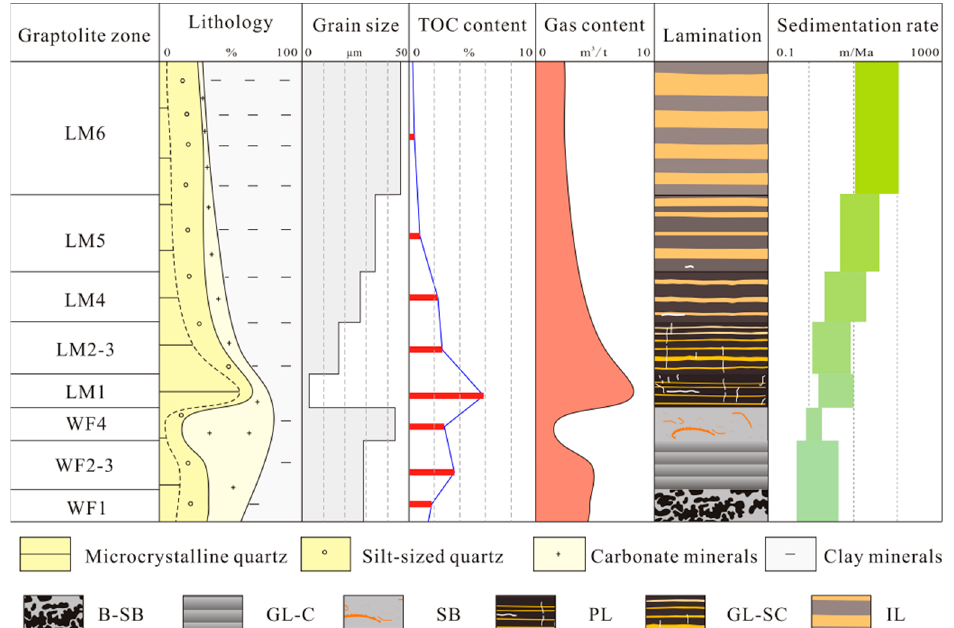
Figure 5. Characteristics of the sweet-spot interval of the Wufeng–Longmaxi shale on the Yangtze Platform, South China. This figure is modified from [29]. B–SB: Bioturbated-type massive bedding;